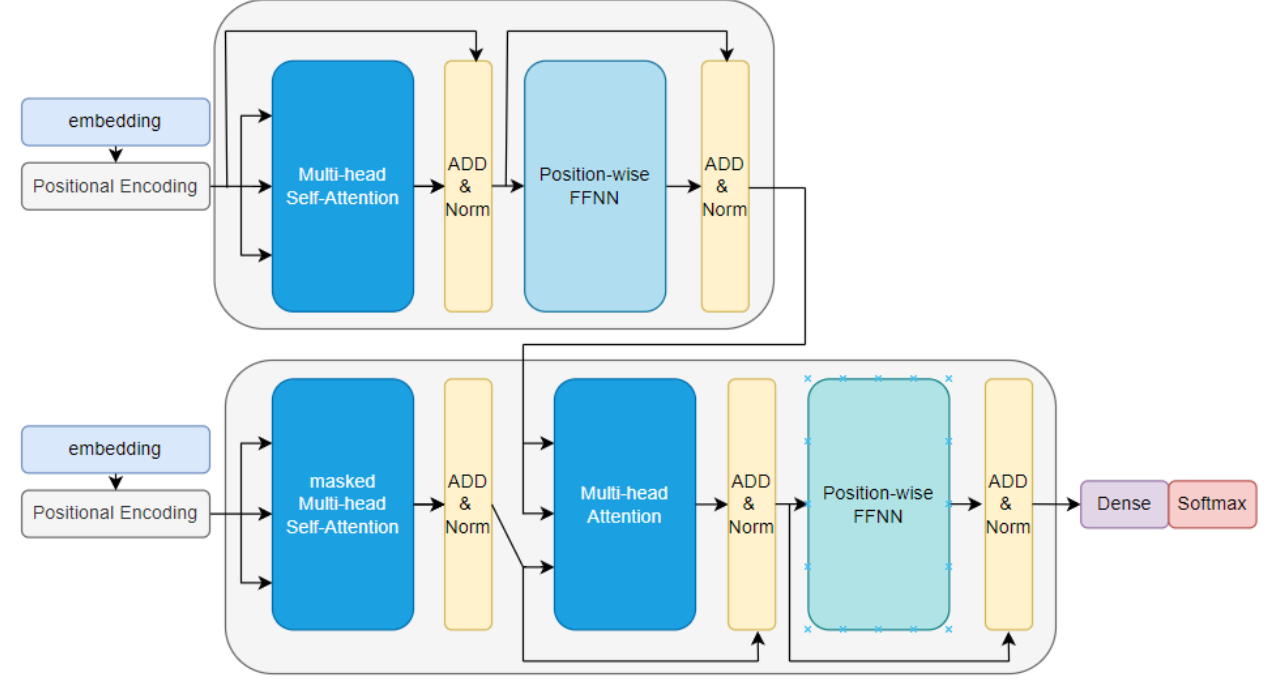
Figure 1. Transformer